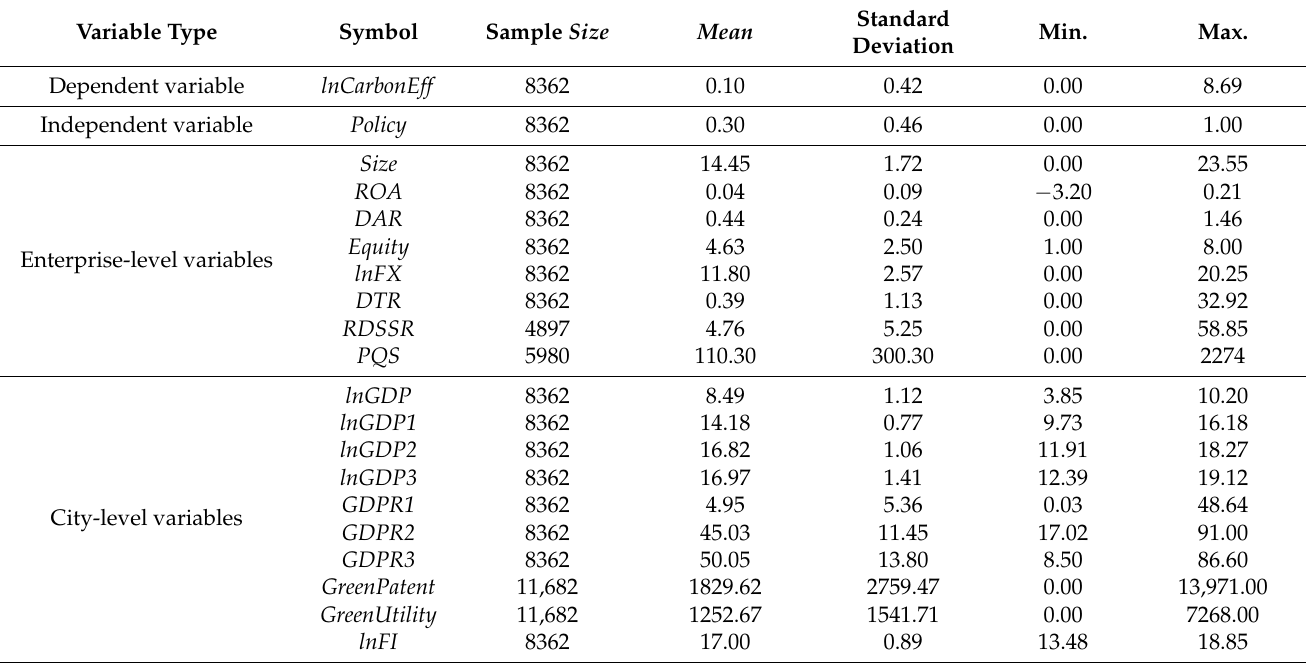
Table 2. Descriptive